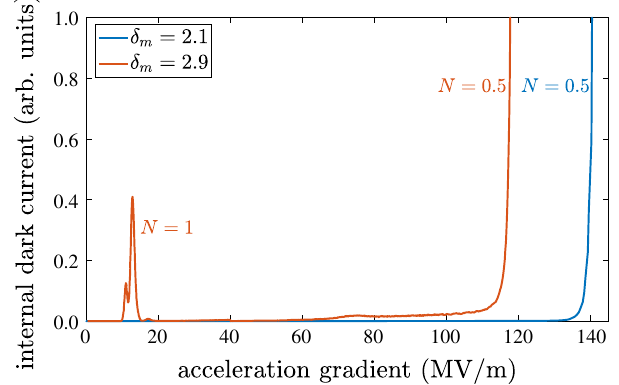
FIG. 6. CST PIC simulation result of the internal dark current intercepted by the axisymmetric elliptical sidewall plotted vs the gradient. A decrease of the δ m value from 2.9 to 2.1 cancels the N ¼ 1 multipactor mode, whereas the N ¼ 0 . 5 mode